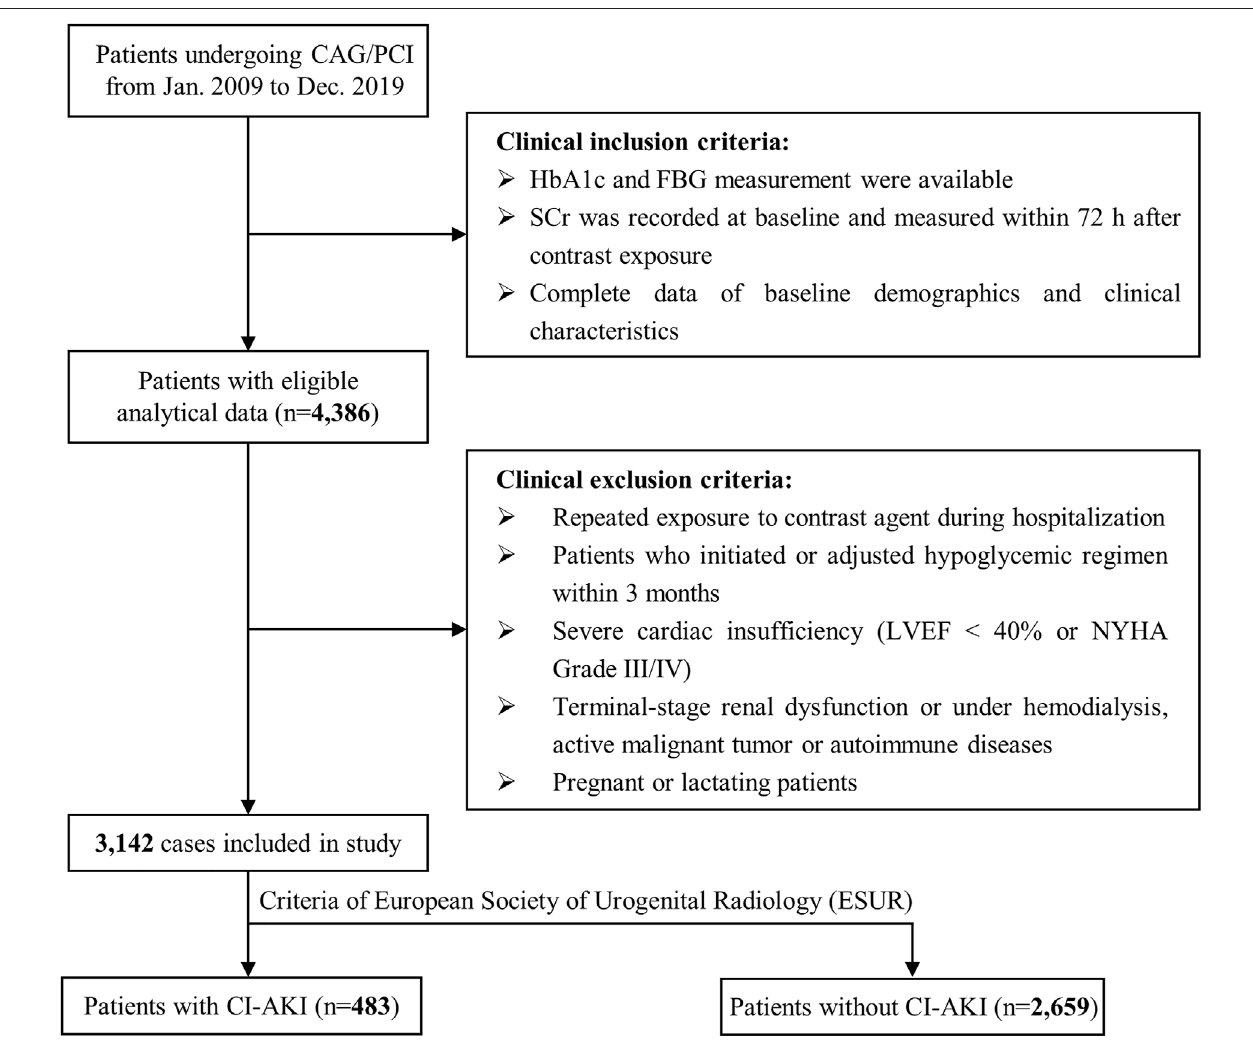
FIGURE 1 | Inclusion and exclusion fl owchart. The fl owchart described the inclusion and exclusion criteria of study participants. CAG indicates coronary angiography; CI-AKI, contrast-induced acute kidney injury; FBG, fasting blood glucose; HbA1c, glycated hemoglobin; LVEF, left ventricular ejection fractions; NYHA, New York Heart Association; PCI, percutaneous coronary intervention; SCr, serum creatinine.